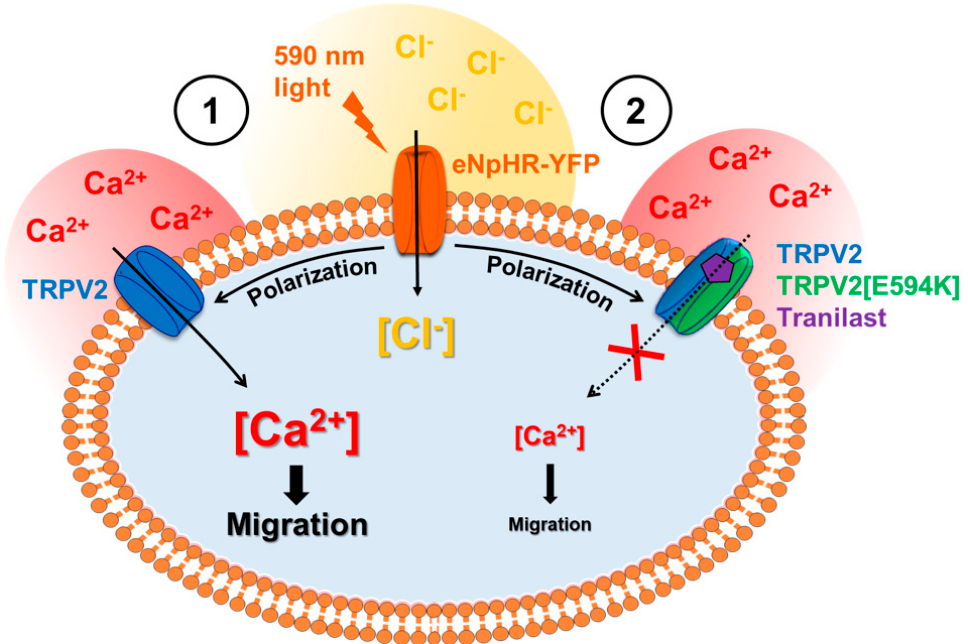
Figure 6. Schematic model of the e ff ect of light-induced activation of halorhodopsin pump on the activation of calcium constitutive entry pathway through TRPV2 channels and on the modulation of cell migration. ( 1 ) Light stimulation of C2C12 myoblasts expressing eNpHR (orange) leads to membrane polarization by chloride ion entry (yellow) which gives rise to constitutive calcium entry (red) through TRPV2 channel (blue) by increasing the driving force for Ca 2 + across the plasma membrane. This light-induced calcium entry increases cell migration in a manner that can be abolished ( 2 ) by the TRPV2 inhibitor Tranilast (purple) and the negative-dominant TRPV2[E594K] transcript (green).